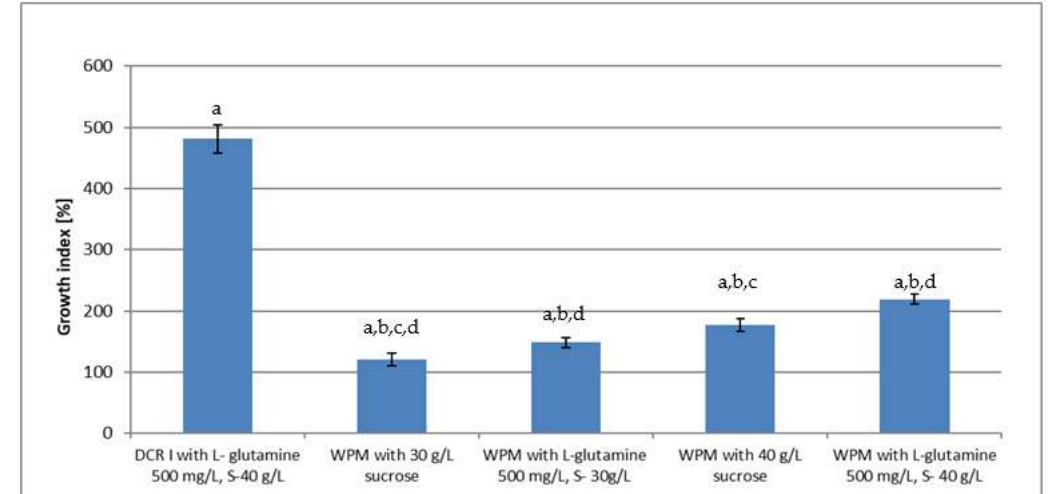
Figure 3. Hairy roots of K-1 line growing in liquid DCR I medium supplemented with L-glutamine 500 mg/L, 30 g/L sucrose.